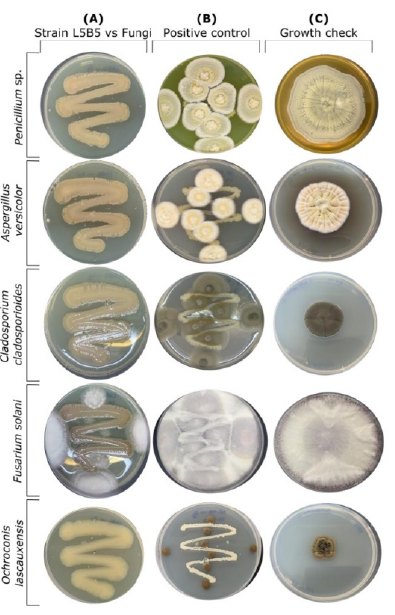
Figure 3. Pseudomonas sp., strain L5B5, fungal inhibition of growth assay ( A ), in comparison with positive control using an environmental bacterium without antifungals production ( B ) and normal fungal growth in NA ‐ Glycerol plates ( C ).